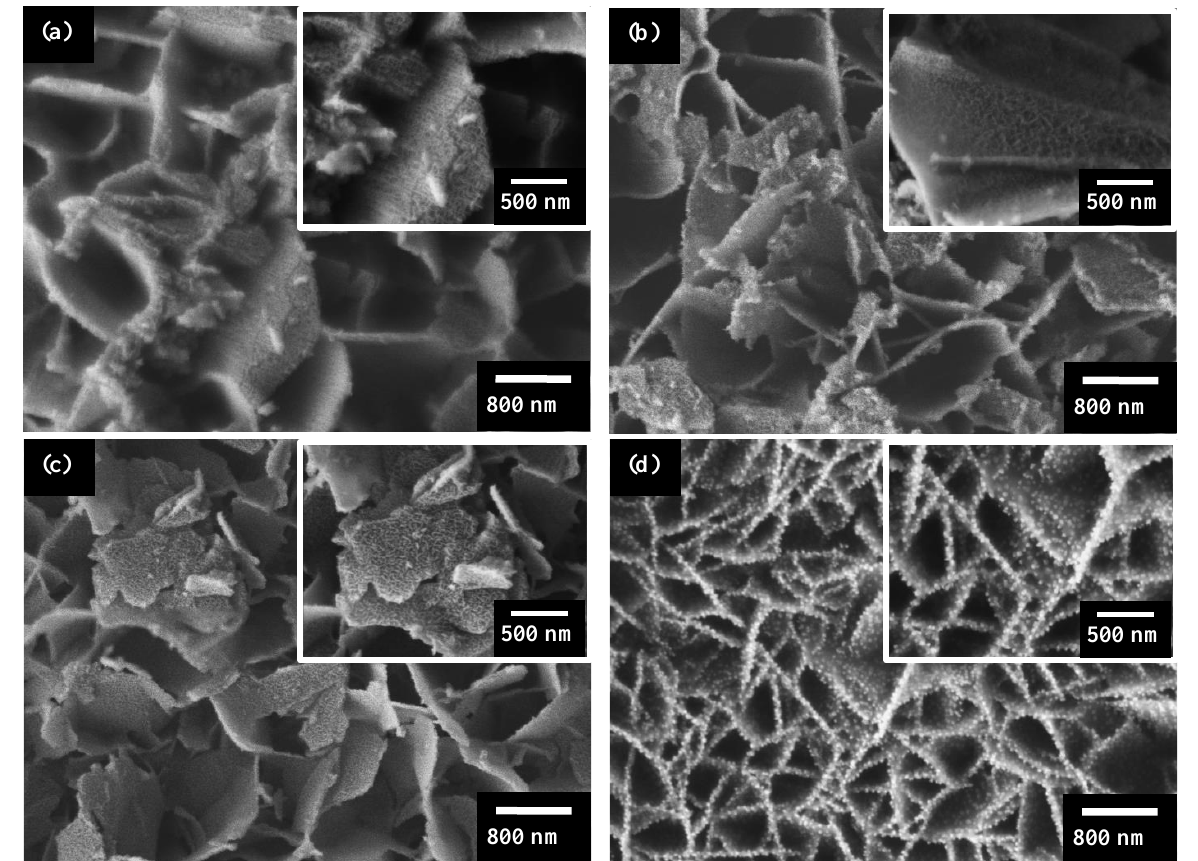
Figure 4. SEM surface morphologies: ( a ) NaOH_T fresh catalyst; ( b ) NaOH_T + R reduced catalyst; ( c ) NaHCO 3 _T fresh catalyst; ( d ) NaHCO 3 _T + R reduced catalyst.